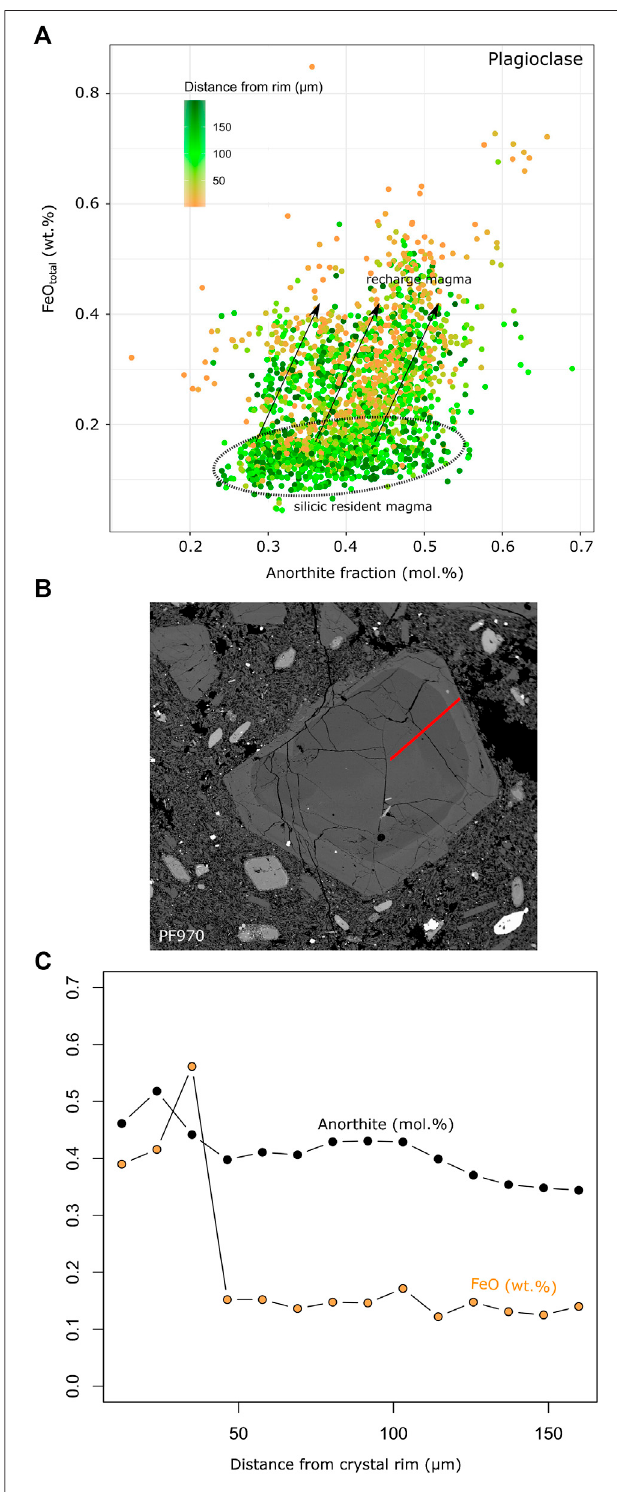
FIGURE 8 | Evidence for magma hybridization in plagioclase. (A) Systematics of anorthite (mol%) and FeO t (wt%) in plagioclase from all studied samples. The data are color coded for distance from the crystal rims in µm (orange to green). Dashed area indicates the predominant silicic